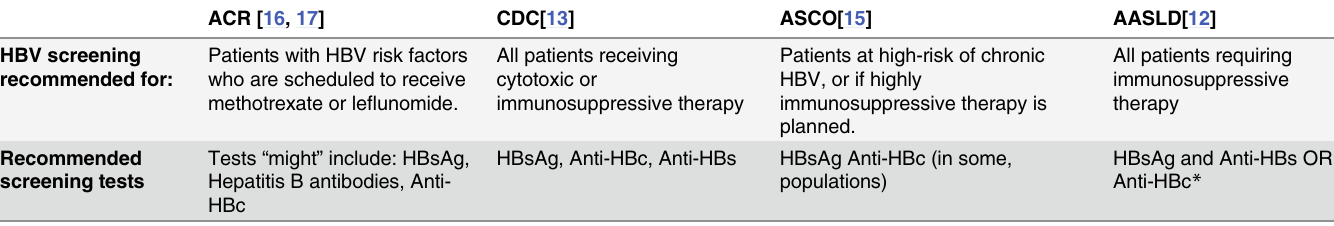
Table 4. Summary of current guidelines regarding HBV